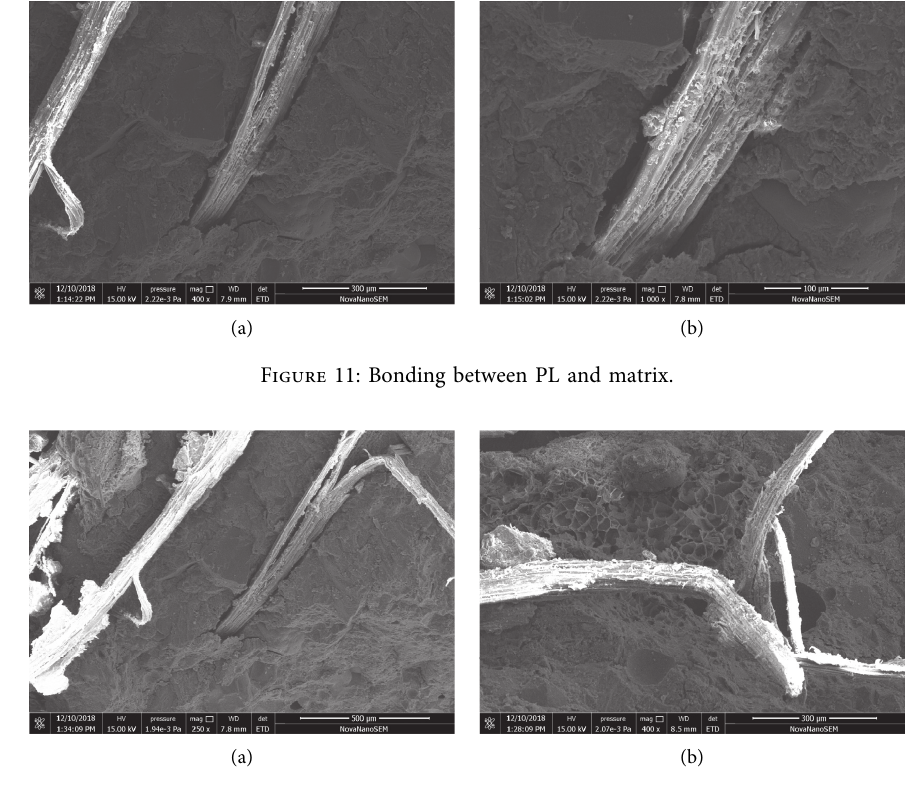
Figure 12: Distribution and bonding image.